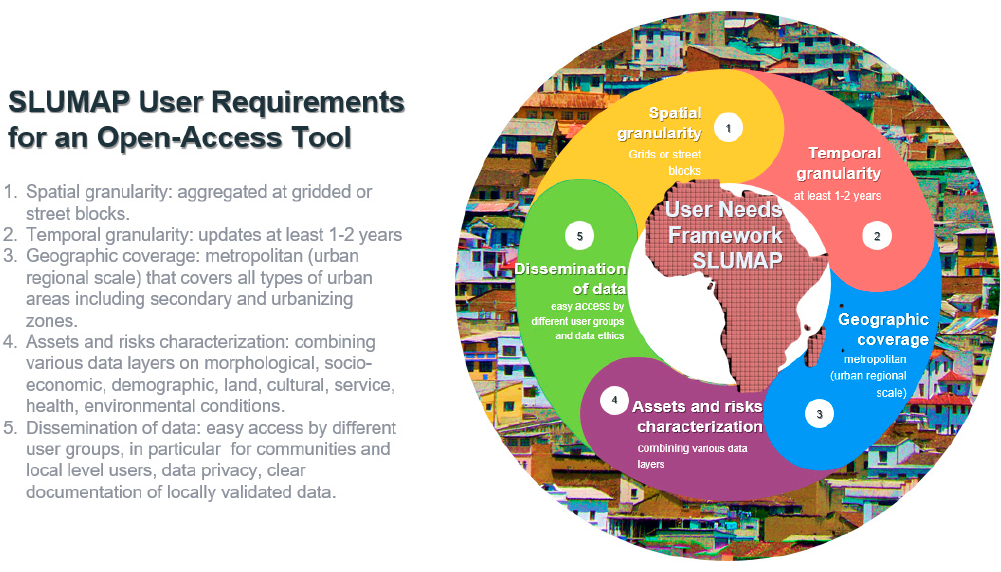
Figure 17. Summary of user information requirements on deprived urban areas.